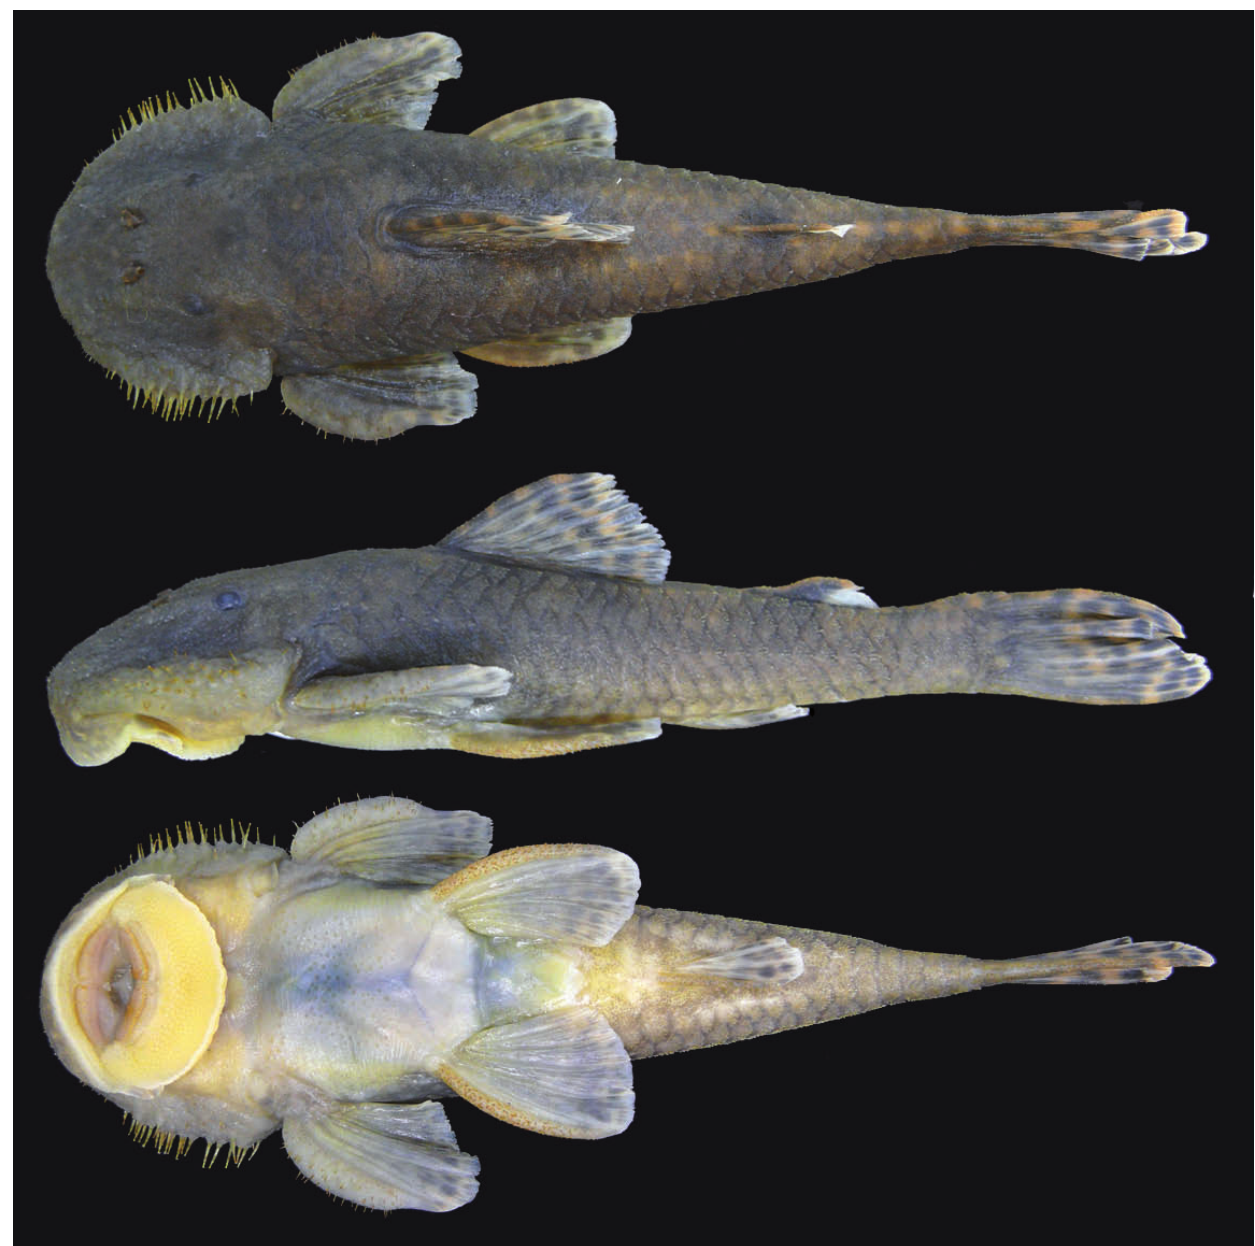
Fig. 1. Pareiorhaphis scutula , holotype, male, MCP 44046, 84.7 mm SL, córrego Prainha, tributary to rio Piracicaba, Nova Era, rio Doce drainage, Minas Gerais,